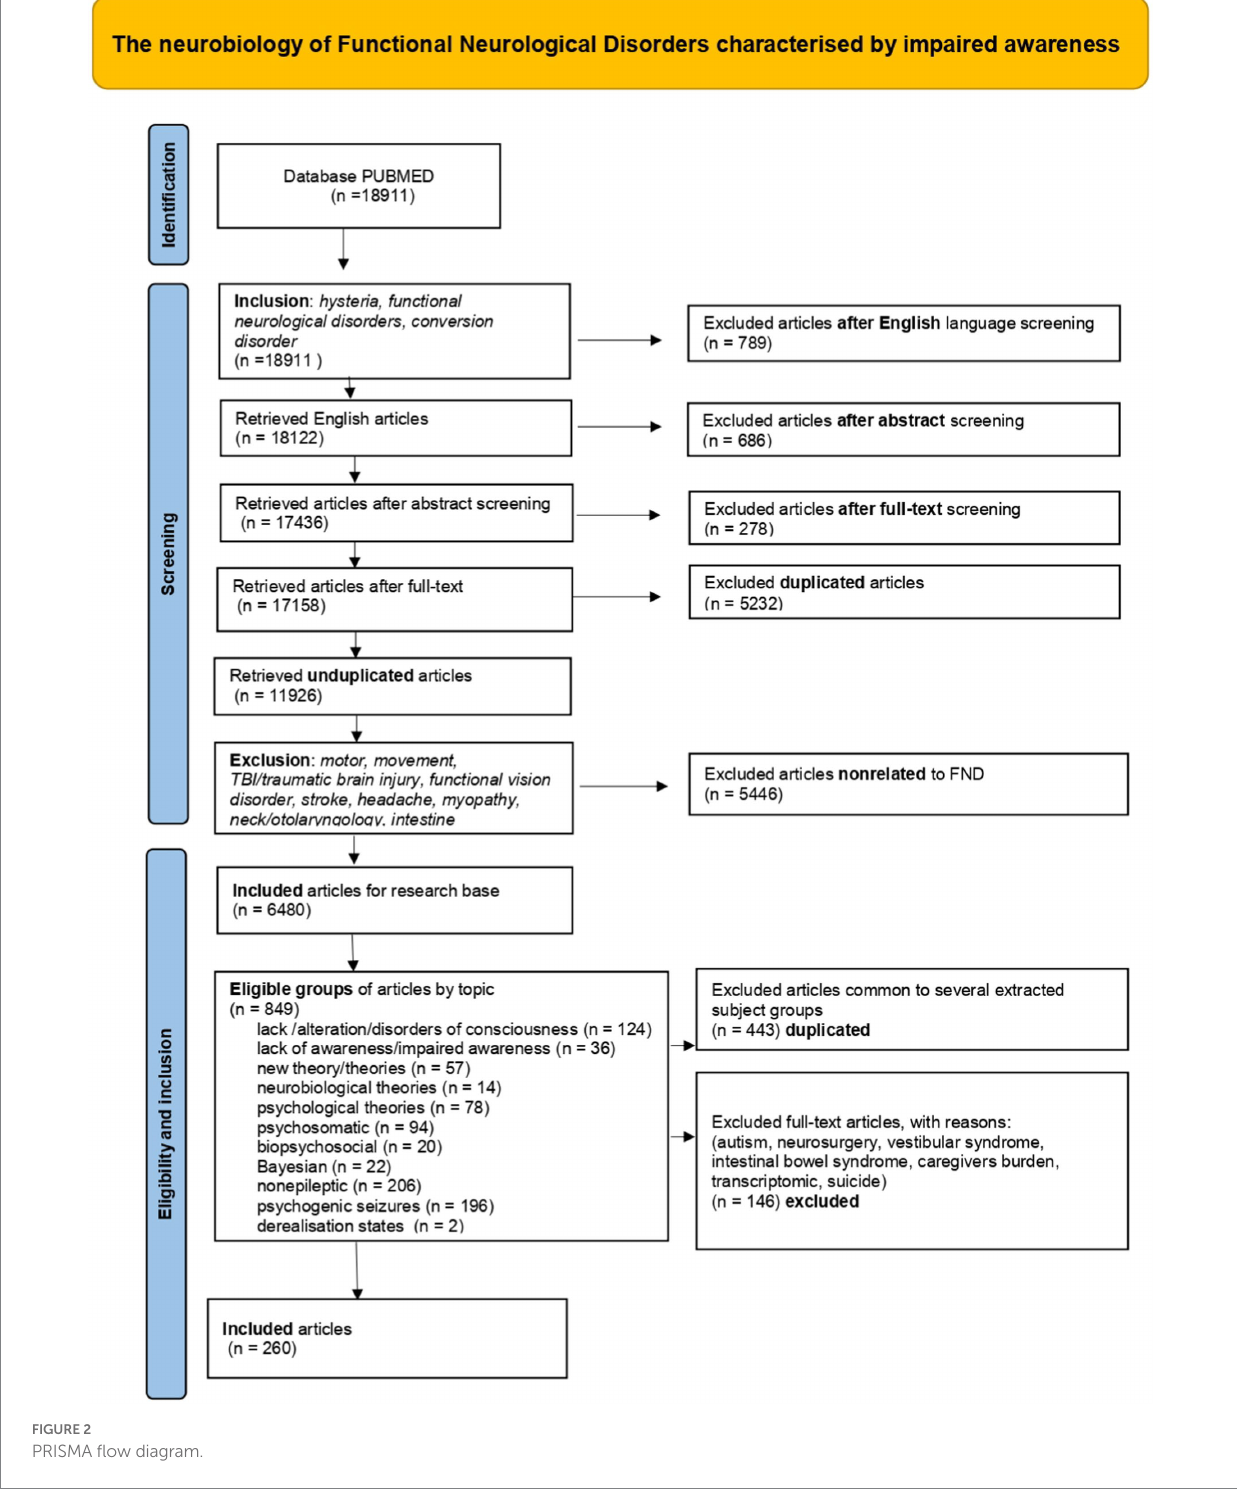
FIGURE 2 PRISMA flow